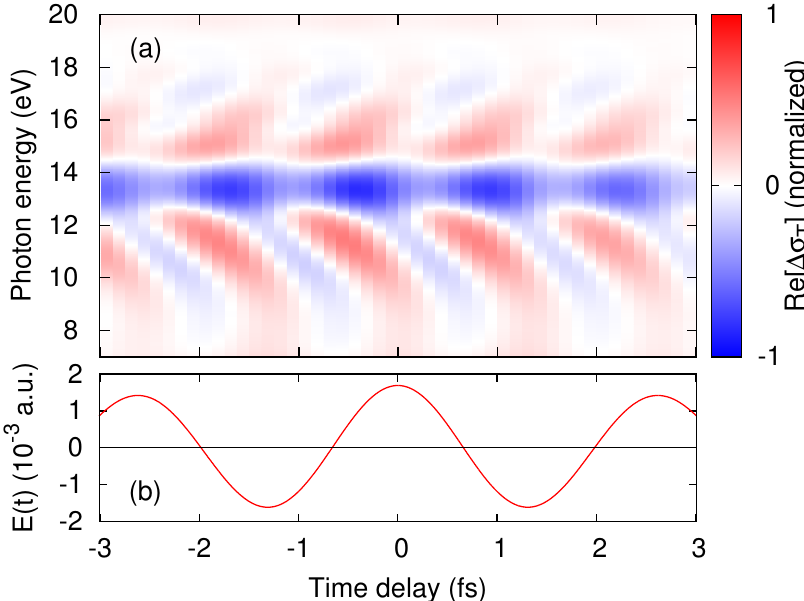
Figure 2. ( a ) real part of the transient conductivity of monolayer h -BN under the IR pump pulse for the x -direction in Figure 1a; ( b ) the time-profile of the applied pump electric field. The result is computed by TDDFT with